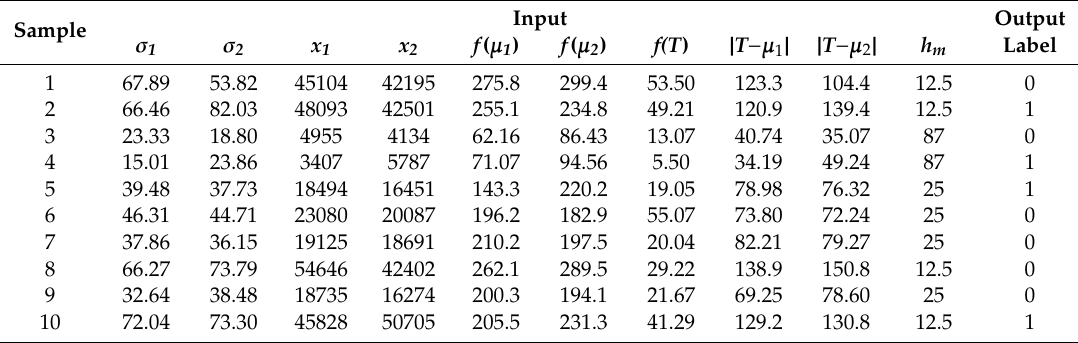
Table 2. Examples of the feature parameters and their